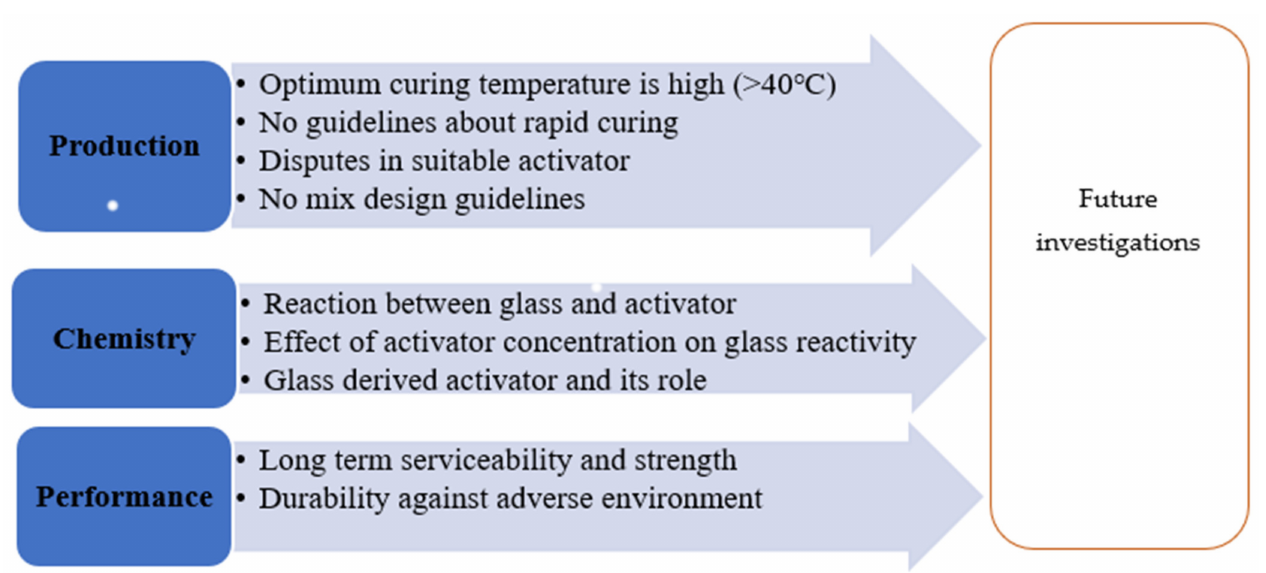
Figure 28. Current research gaps and future research questions in the production, chemistry, and performance of WG-based geopolymer